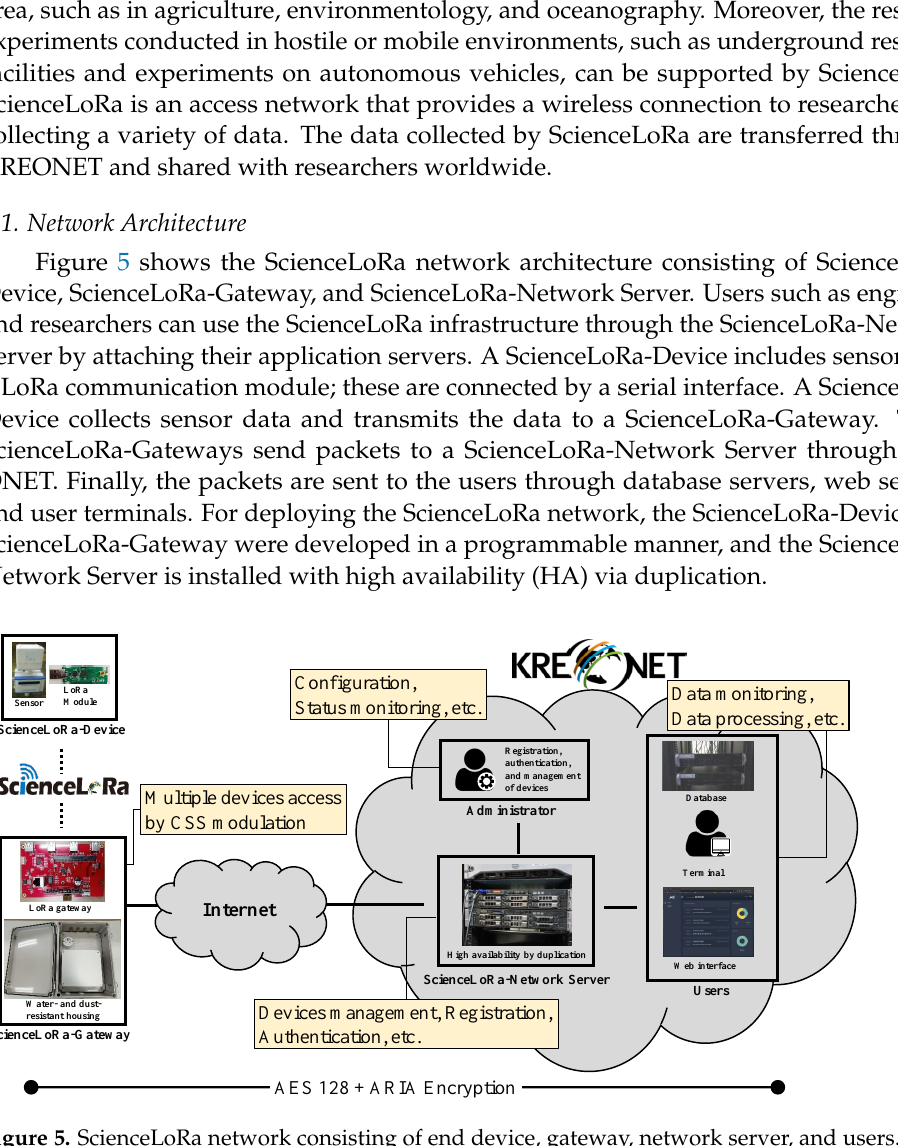
Figure 5. ScienceLoRa network consisting of end device, gateway, network server, and